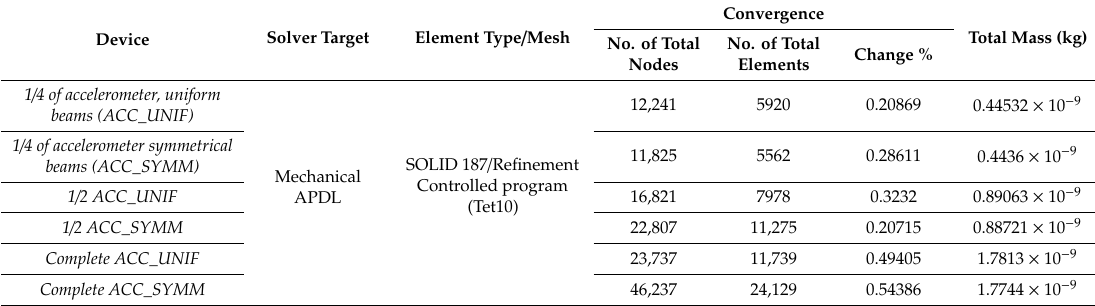
Table 6. Technical details about Finite Element Analysis